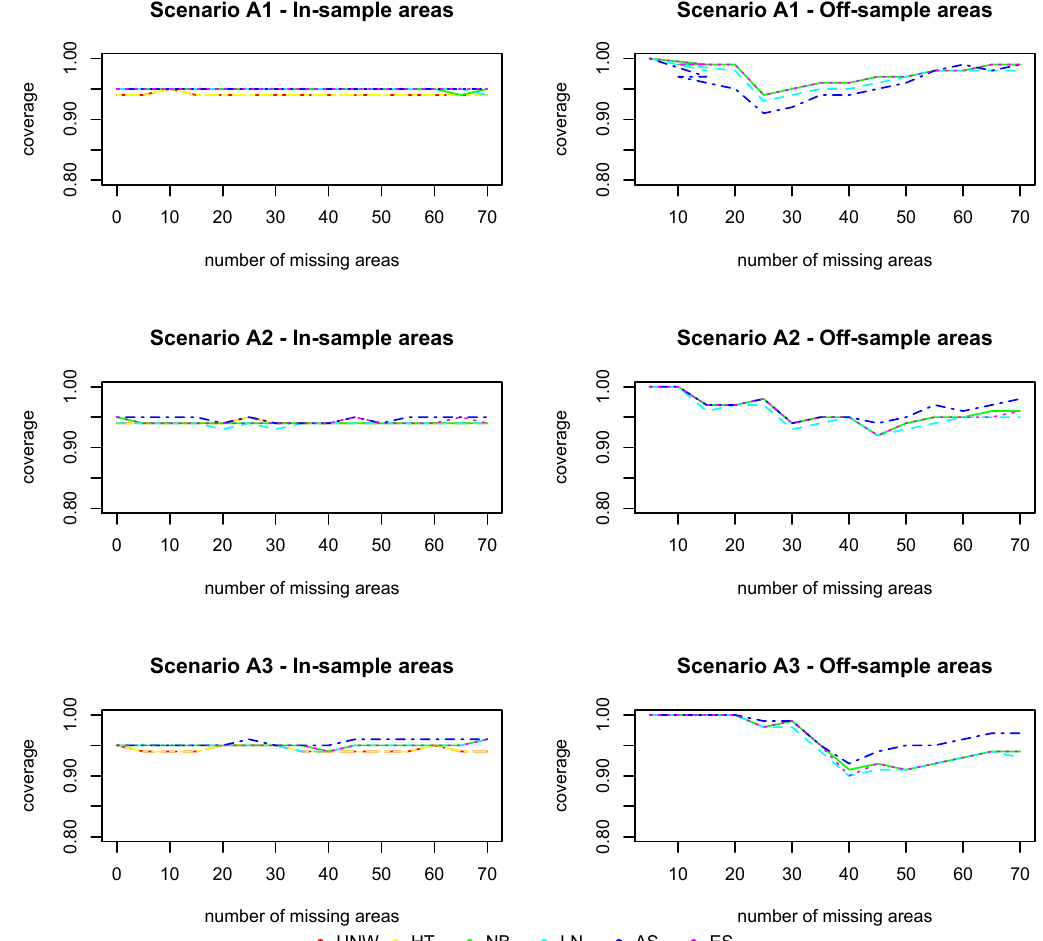
Figure 5. Simulation 1: Coverage probabilities. UNW = unweighted estimator; HT = Horvitz– Thompson estimator; NB = naive binomial model; LN = logit-normal model; AS = arcsine model; ES = effective sample size model. ( A 1 ) : σ 2 v = 0.15 and σ 2 u = 0.03; ( A 2 ) : σ 2 v = 0.09 and σ 2 u = 0.09; ( A 3 ) : σ 2 v = 0.03 and σ 2 u =